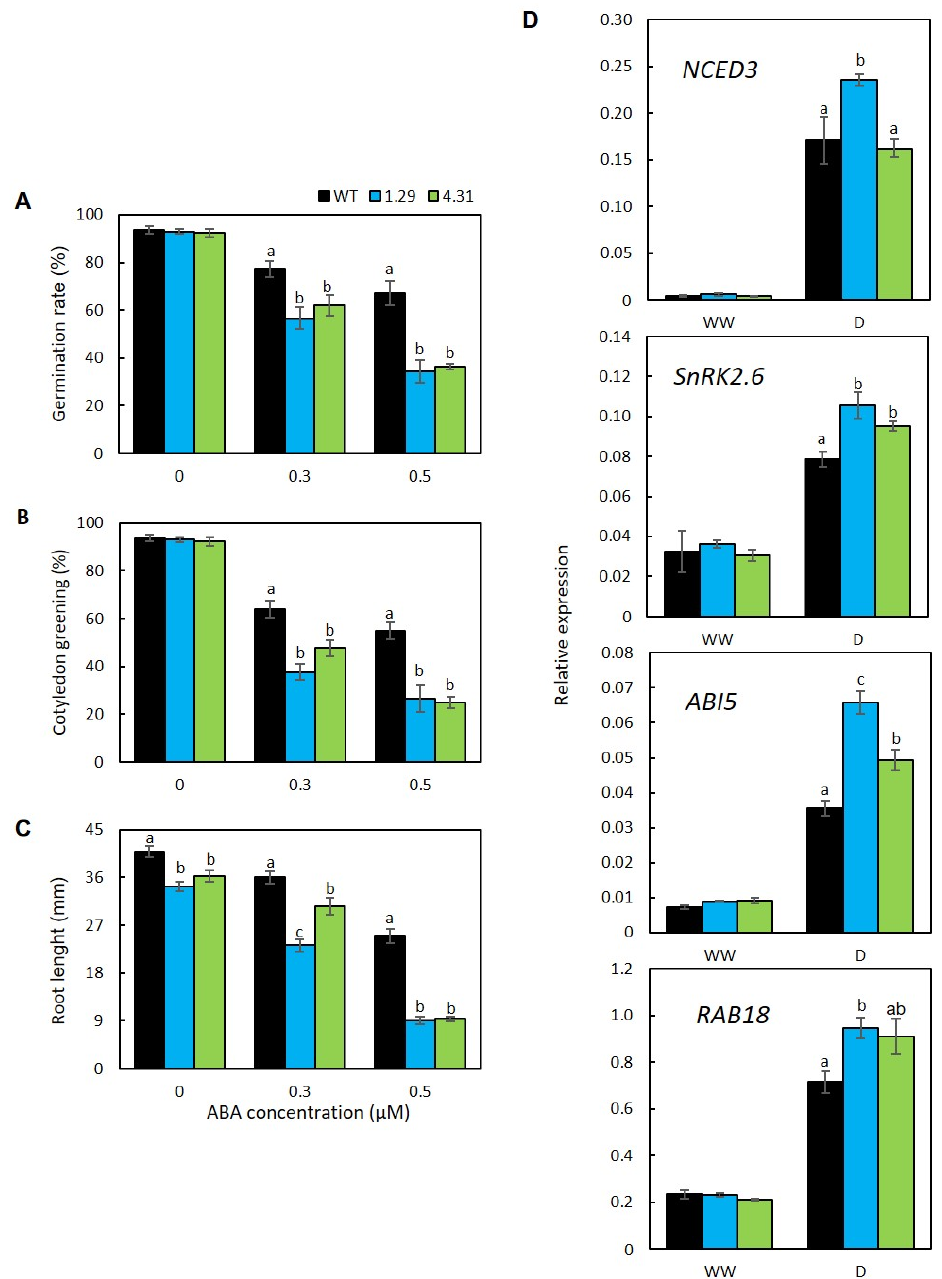
Figure 5. ABA sensitivity assays and expression of ABA-related genes in wild-type (WT) and transgenic plants ectopically expressing GmRR34 (independent lines 1.29 and 4.31). ( A ) Germination rate, ( B ) green cotyledon rates ( n = 3 replicates per genotype per treatment, 100 seeds per replicate) and ( C ) root length ( n = 10) of WT and transgenic plants on MS medium supplied with different concentrations of ABA (0, 0.3 and 0.5 µM). ( D ) Relative expression levels of AtNCED3 , AtSnRK2.6 , AtABI5 and AtRAB18 under well-watered (WW) and 10-day drought (D) conditions ( n = 3). Error bars indicate standard errors. Statistically identified differences among three genotypes under the same treatment were indicated by different letters ( p -value < 0.05).